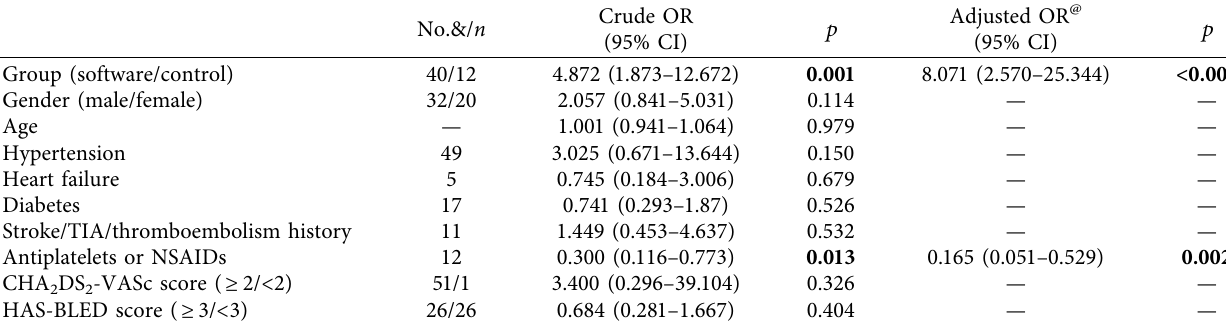
Figure 6: Histogram of antithrombotic treatment and the choice of anticoagulants in the two groups. Table 2: Factors associated with the guideline-directed antithrombotic treatment of